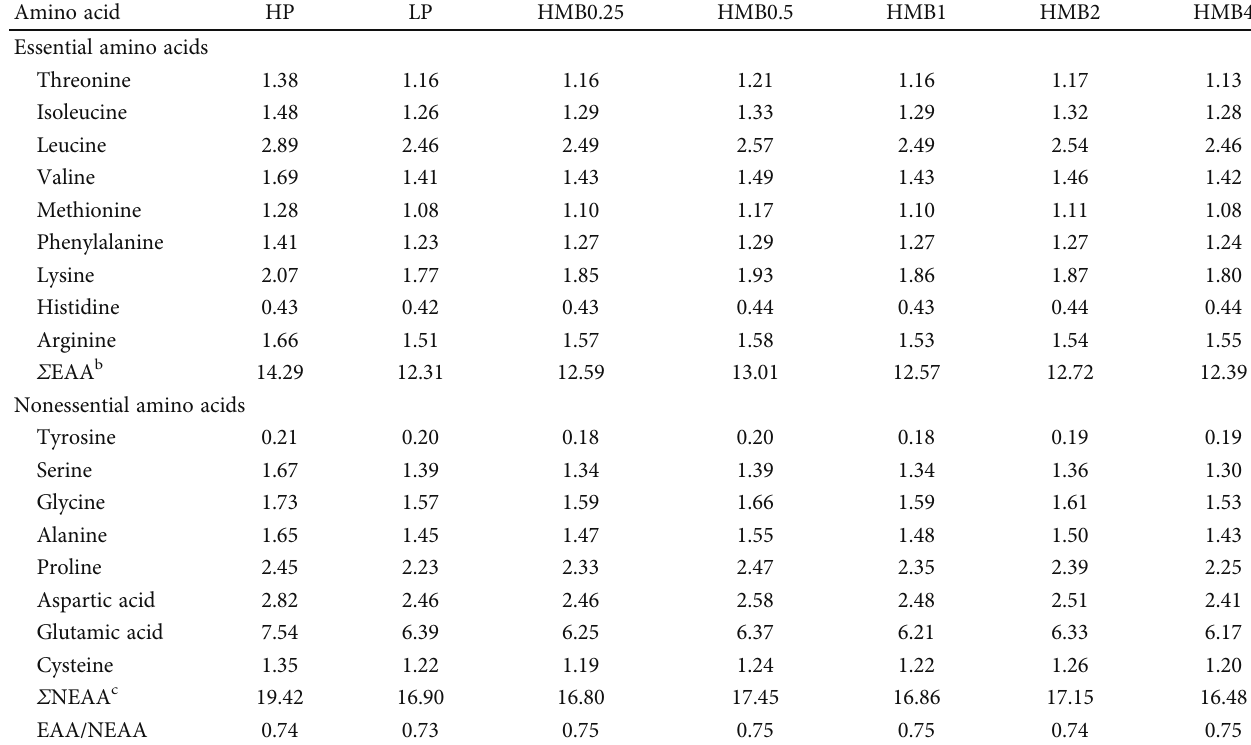
Table 2: Amino acid composition of the experimental diets (% dry matter) a